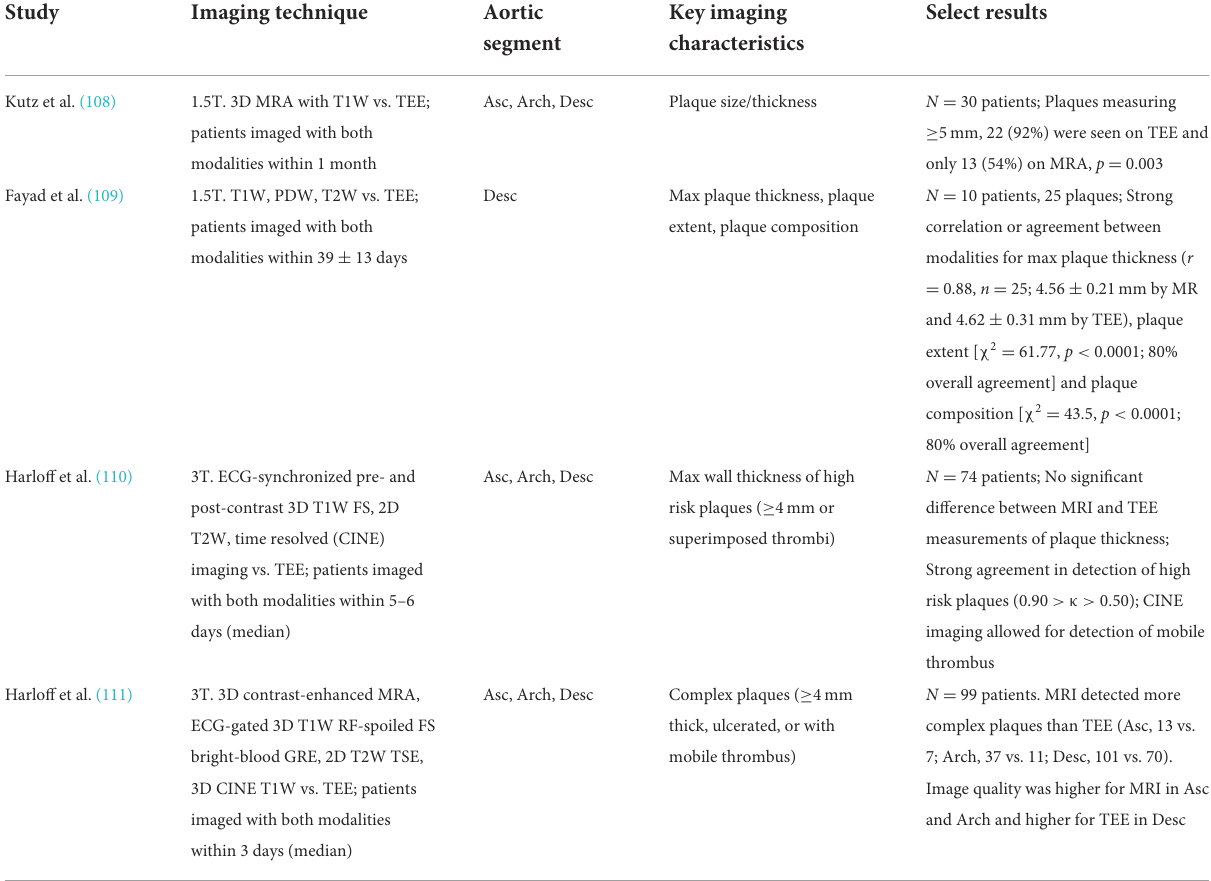
TABLE 4 Comparison of transesophgeal echocardiogram vs. MR imaging of the aortic arch/proximal aorta evaluating plaque thickness. Study Aortic